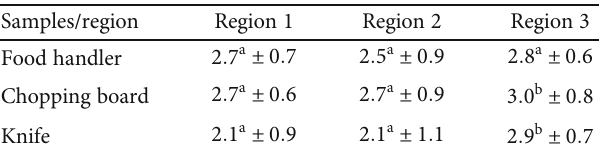
Di ff erent letters in row show signi fi cant di ff erence ( p < 0 : 05 ) as analyzed by Fisher ’ s